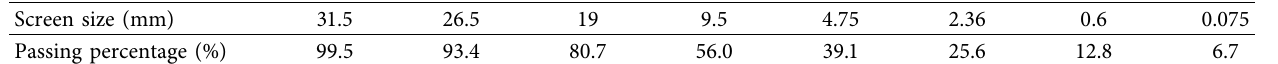
Table 3: CSCS gradation curve.